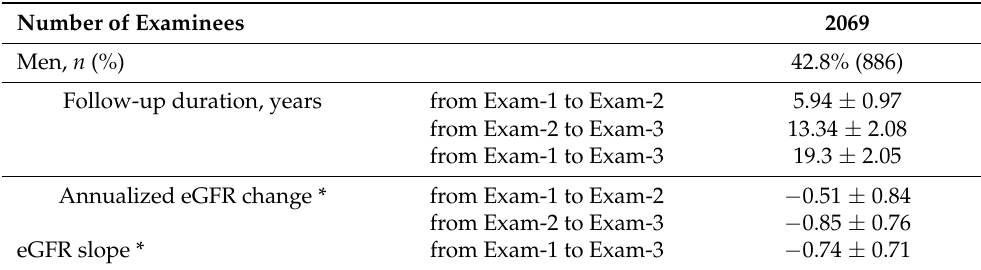
Table 2. Descriptive statistics in 2069 examinees with complete data at all exams for follow-up duration and eGFR data (mean ±